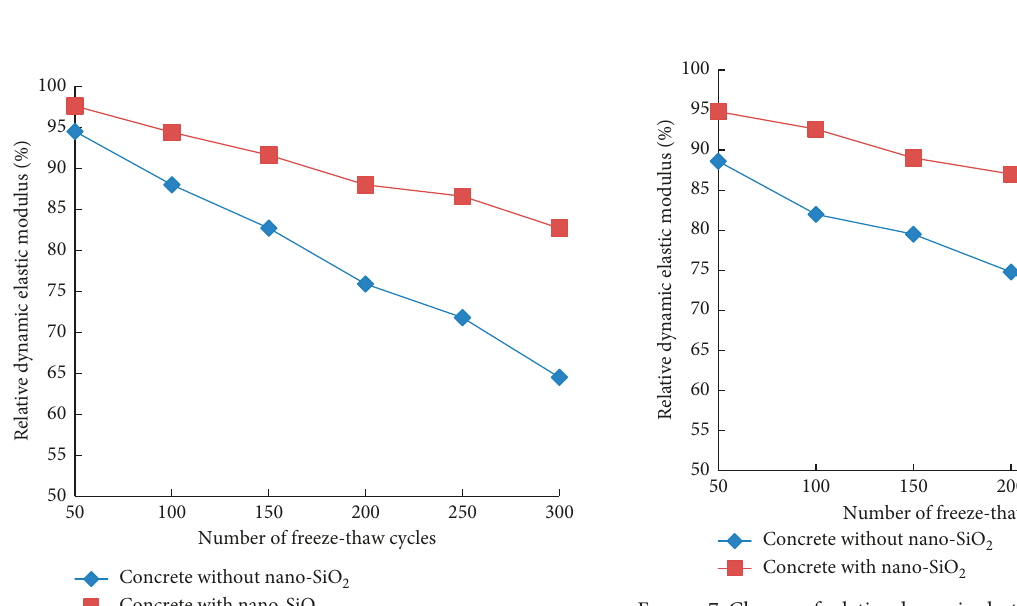
Figure 4: Change of mass loss rate with number of freeze-thaw cycles.